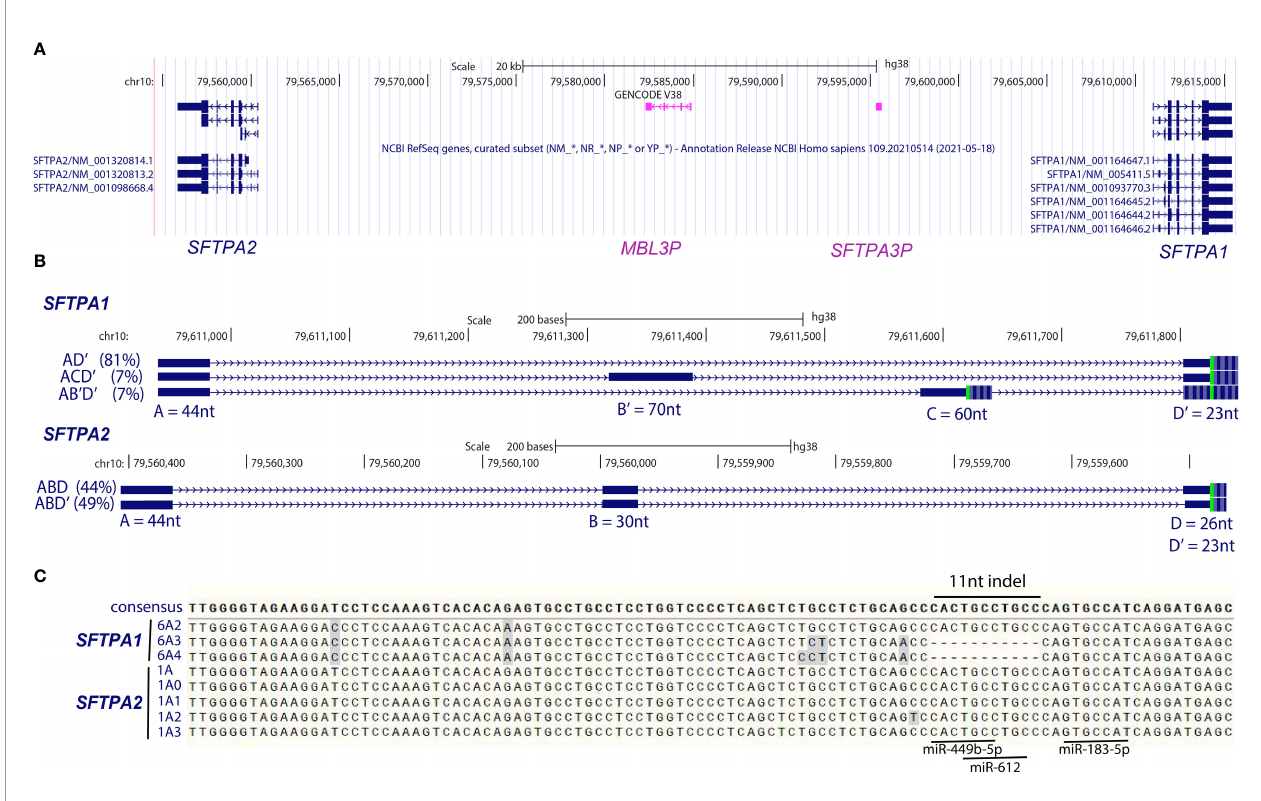
FIGURE 1 | Human SFTPA1 and SFTPA2 genes and 5 ′ -UTR and 3 ′ -UTR variability. (A) The human SFTPA1 and SFTPA2 genes, encoding SP-A1 and SP-A2, respectively, are in opposite transcriptional orientation. The SFTPA3P is an SP-A pseudogene, and the MBL3P is the mannose-binding lectin pseudogene. The orientation shown is from the centromere (left) to telomere (right). (B) SFTPA1 and SFTPA2 5 ′ UTR variability. The 5 ′ -UTR consists of a number of untranslated regions as shown in blue boxes. These regions splice to form a number of transcripts with different 5 ′ -UTR. The most common splice variants for SFTPA1 and SFTPA2 are shown and their relative presence in the general population is shown in parentheses. Regions A, C, and D can exhibit different start sites and region B exhibits different stop sites. For example, “ A ” is found in transcripts with a start site at A, A ′ , or A ′′ . The size of A is 44nt, of A ′ is 40nt and of A ′′ is 35nt. The C is 60nt long and the C ’ is 63nt long. Region “ B ” on the other hand is found in transcripts, having the same start site but different end region. So B is 30nt long and B ′ 70nt. The nucleotide size of each region is noted. In-frame start codons are indicated by a green vertical line. Adapted from (54). (C) The 3 ′ -UTR has been identi fi ed with sequence variability as well as small insertions/deletions (indel). The 11-nt indel of the 3 ′ -UTR is shown along with the seed regions for miR-449-b-5p, miR-612, and miR-183-5p, which have been shown to play a role in miRNA-mediated regulation. The fi gure was prepared from the UCSC Browser (hg38) and the alignment was performed by